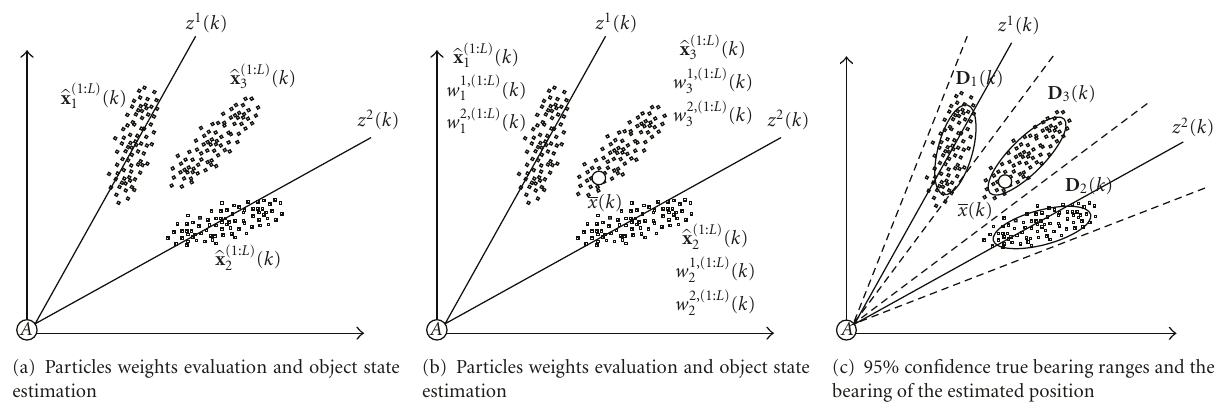
Figure 12: Deviated estimation example where both conditions (15) and (16) should be considered for the visual sensor cooperation.